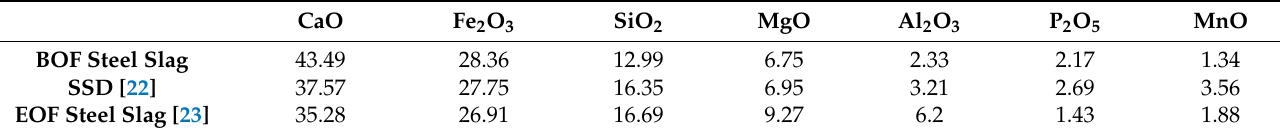
Table 1. Chemical composition of steel slag (Wt.%).